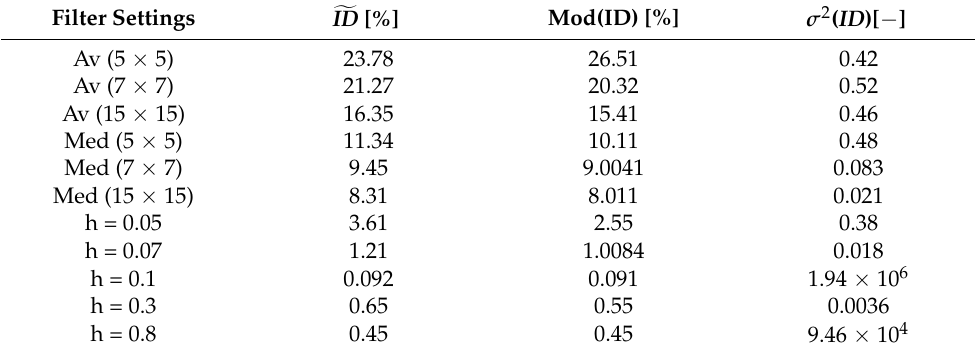
Table 4. Descriptive statistical analysis of various average and median filter’s settings in contrast to selected variants of optimized RNLM filter for MR images corrupted with Rician noise. Filter